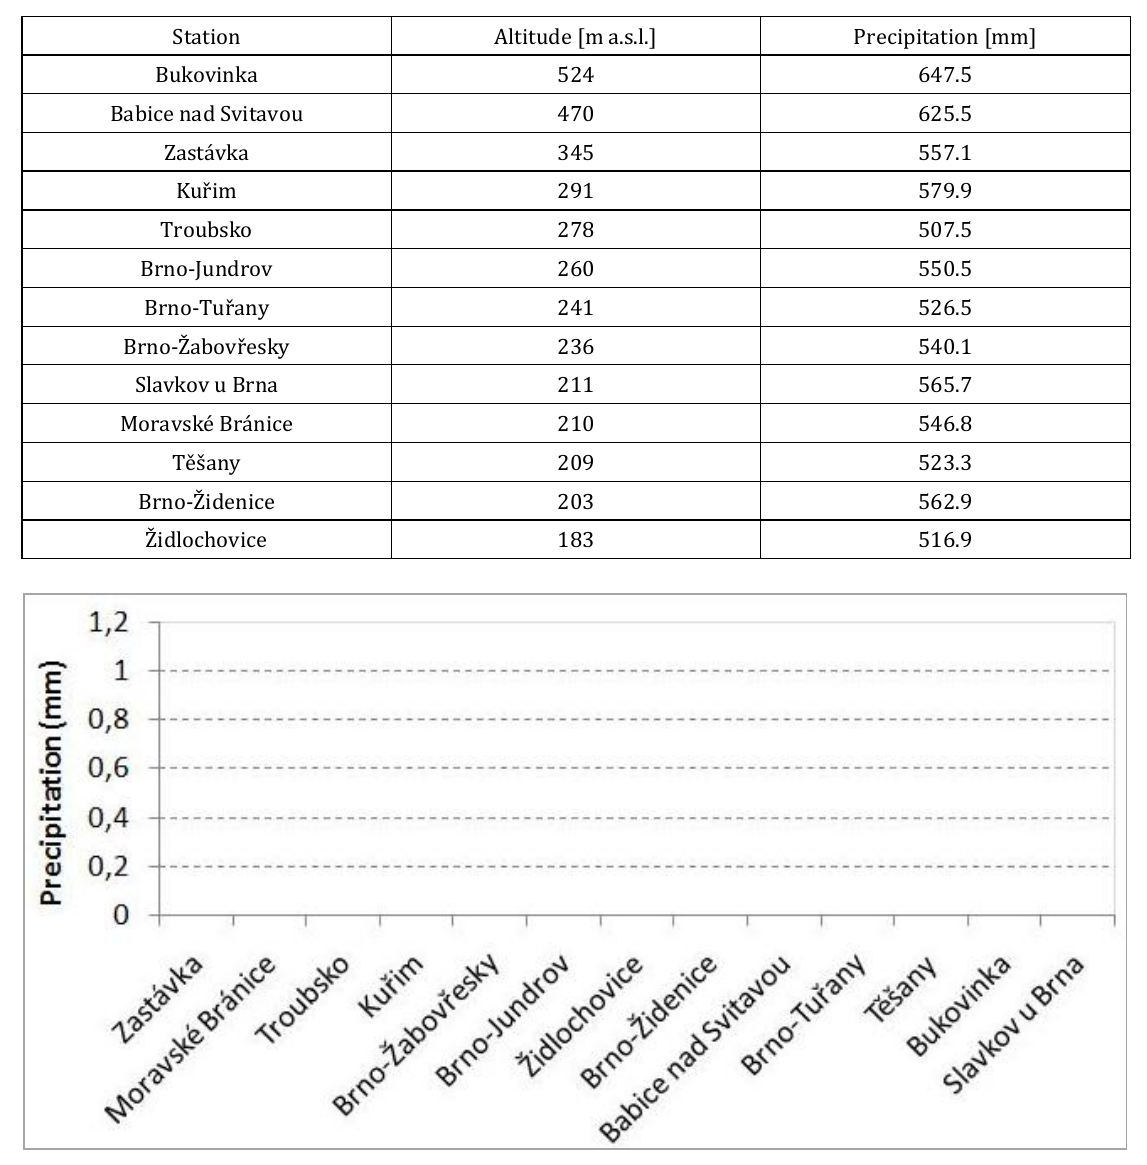
Fig. 6. Daily rainfall totals average in the days of torrential rain in Brno